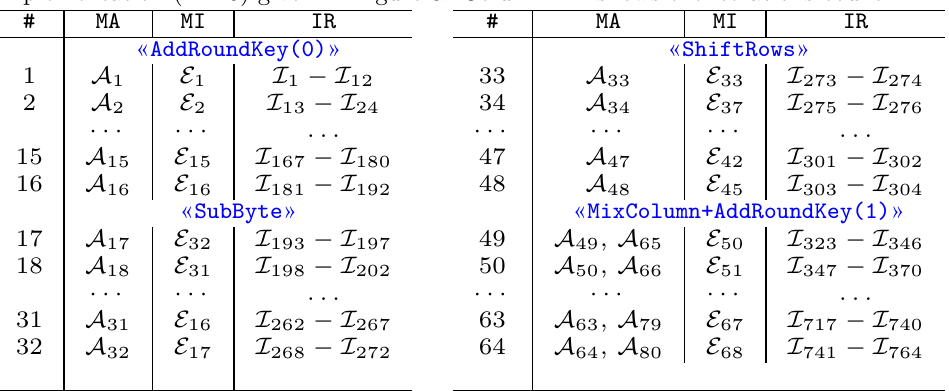
Table 3: Iteration wise result of Equivalence_Mapper (Algorithm 1) for the software implementation ( IMP6 ) given in Figure 3. Column 1 # shows the iterations